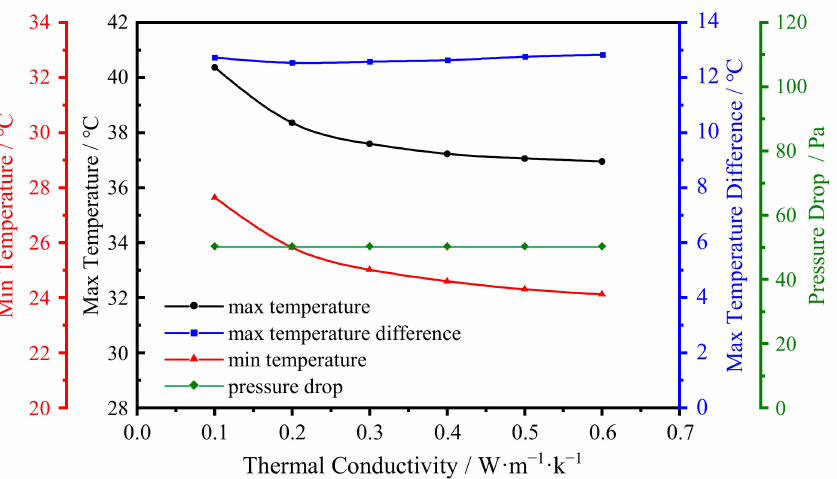
Figure 13. Relationship between the thermal conductivity of the coolant and the MAT, MIT, and MATD of the cell, as well as the pressure drop of the